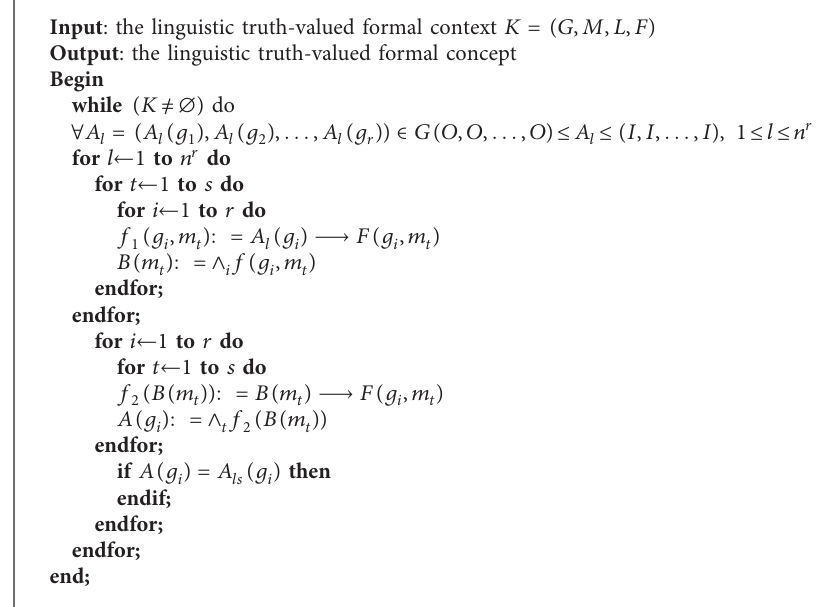
A LGORITHM 1: Linguistic truth-valued formal concepts generation algorithm.